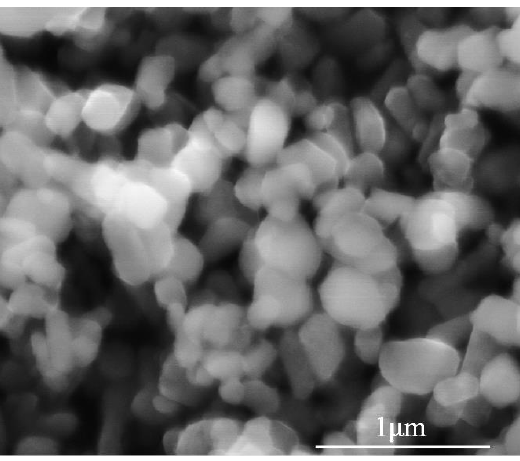
Figure 1. Scanning electron microscope (SEM) image of the nano-W powder.